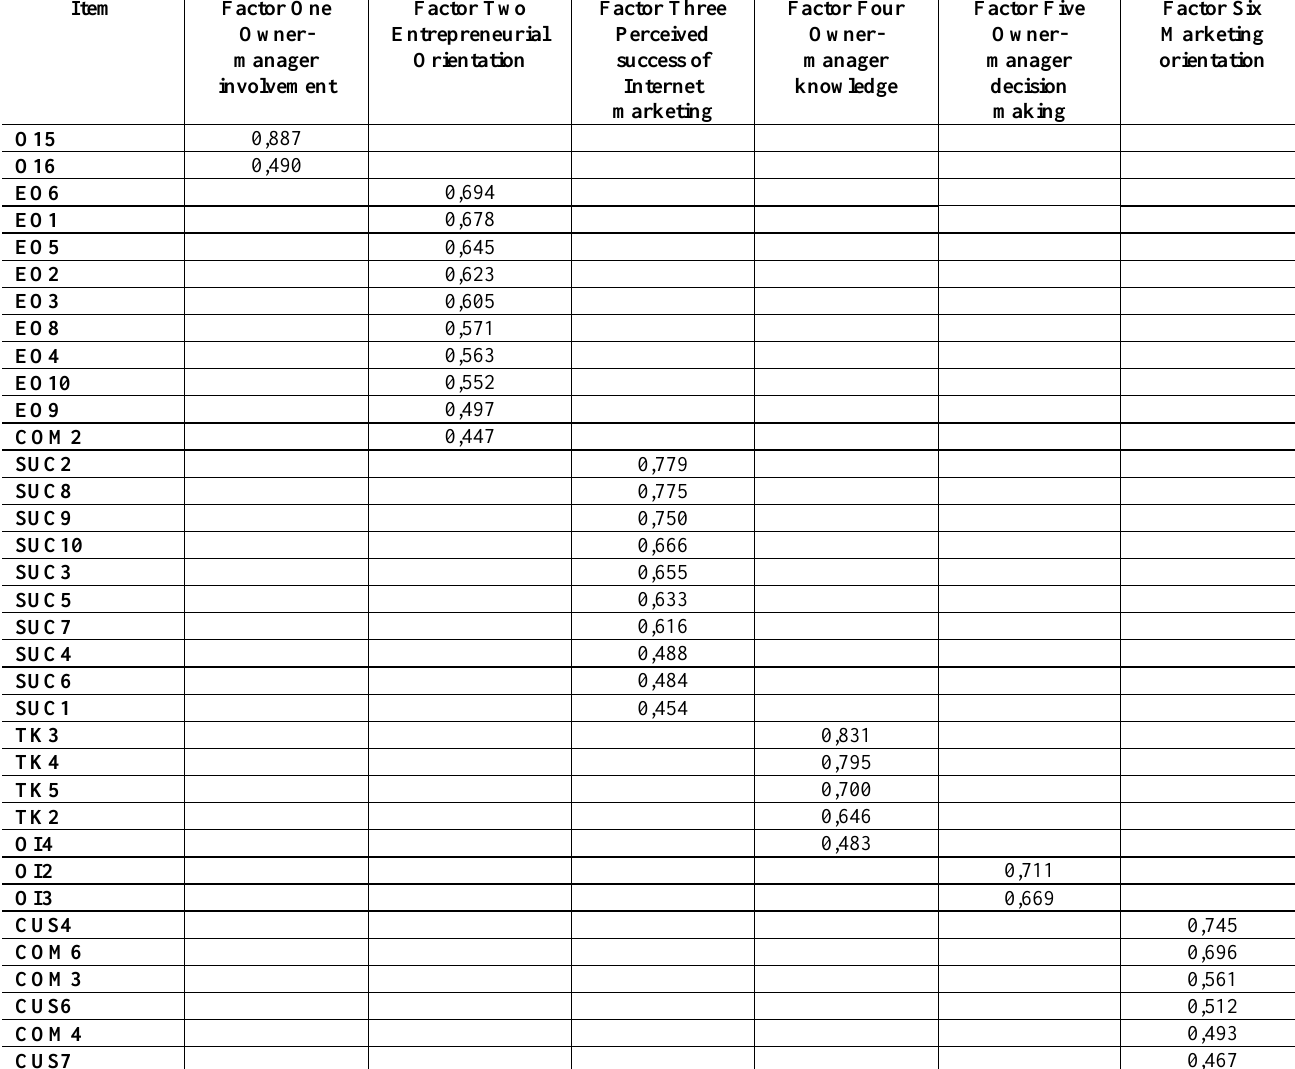
Table 1: Exploratory factor analysis results